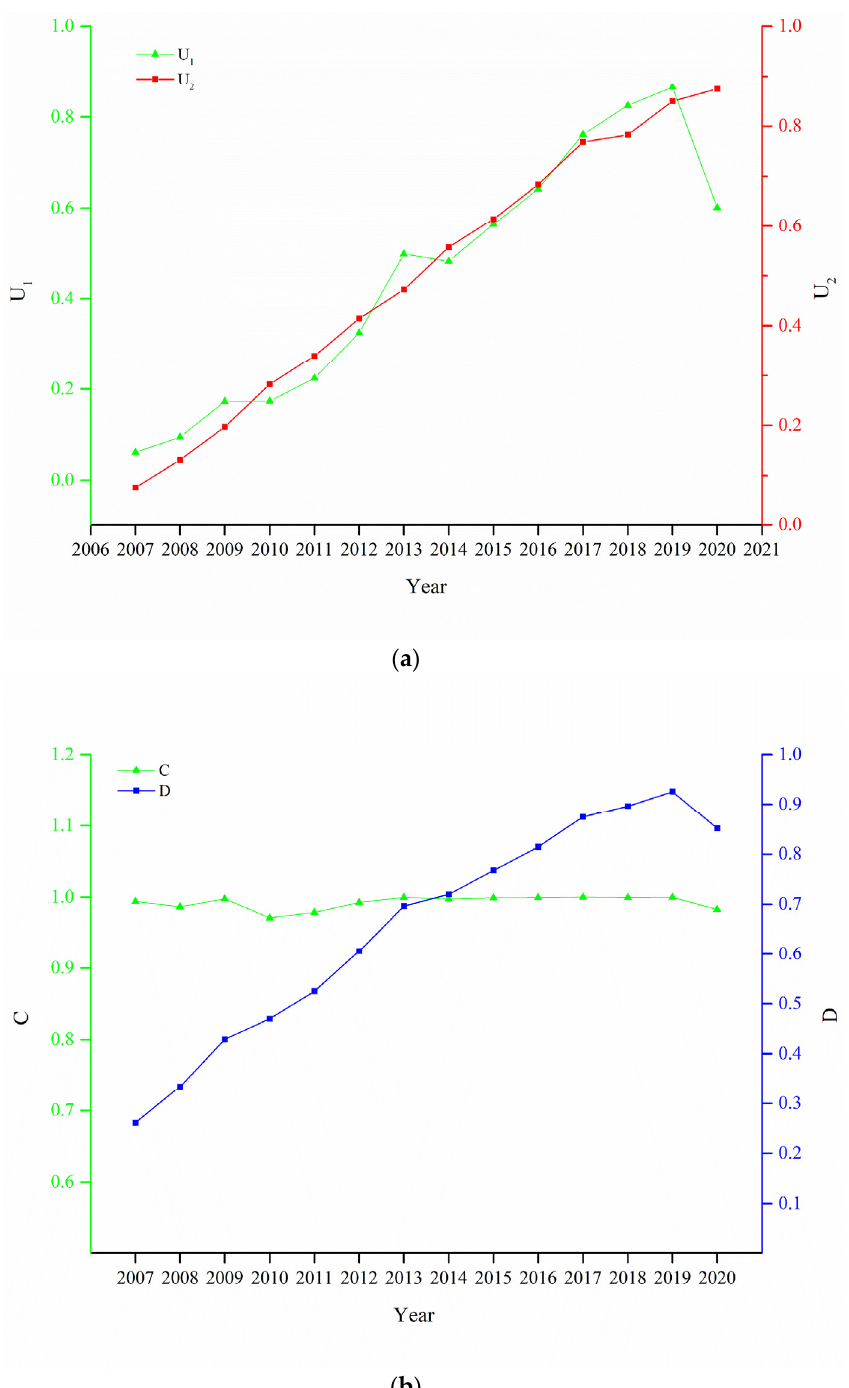
Figure 4. Line charts showing comprehensive evaluation value of cultural tourism and residents’ objective well-being ( a ) and coupling coordination degree ( b ). In chart on the ( a ), U 1 is comprehensive evaluation value of objective well-being of residents, and U 2 is comprehensive evaluation value of cultural tourism. In chart on ( b ), C is coupling degree between cultural tourism and health and welfare, and D represents coupling coordination between the two.